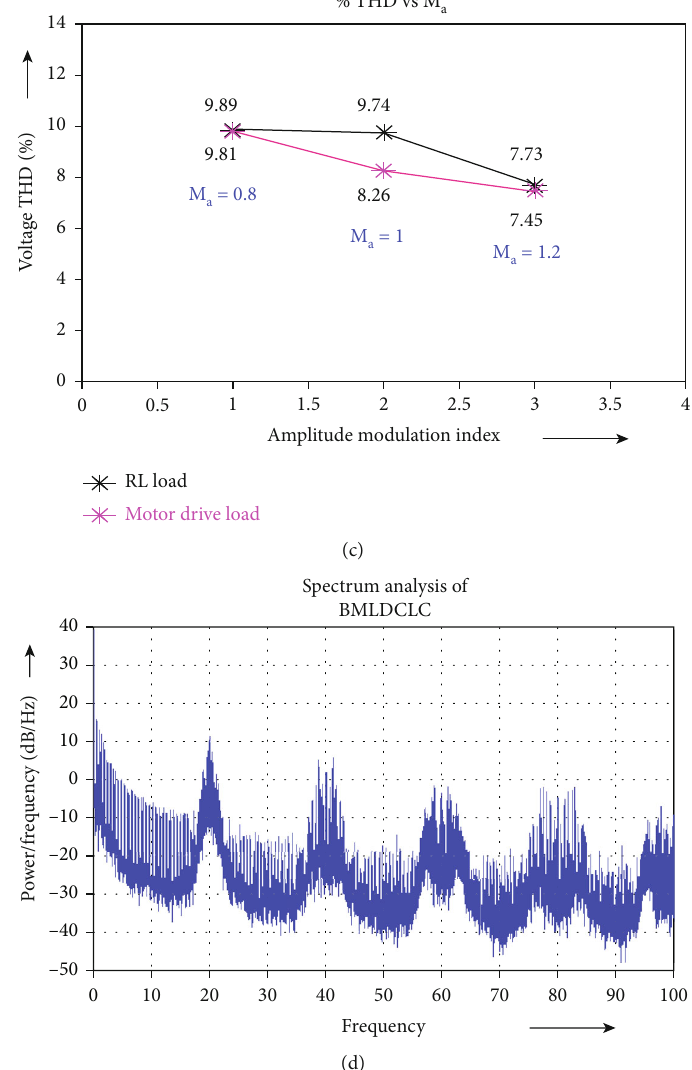
Figure 9: THD investigation of the output voltage of 3 ϕ BMLDCLC. (b) THD investigation of the load current of 3 ϕ BMLDCLC. (c) Power Signal Density analysis for the output voltage of 3 ϕ